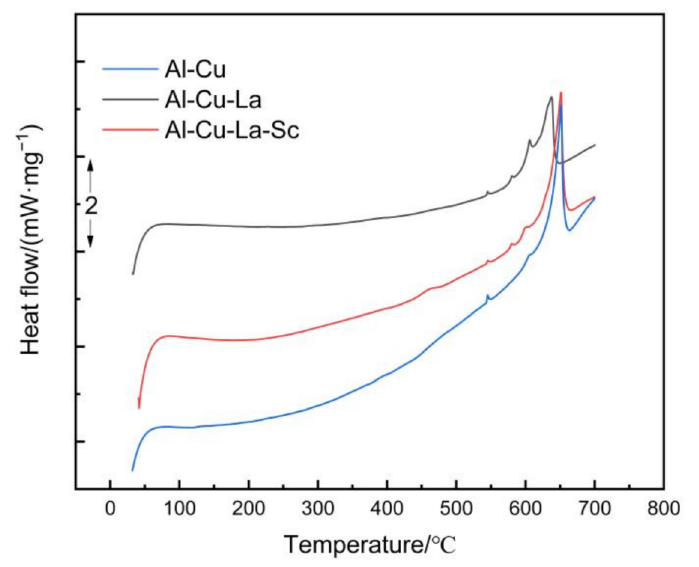
Figure 10. DSC curves of Al-Cu, Al-Cu-La, Al-Cu-La-Sc